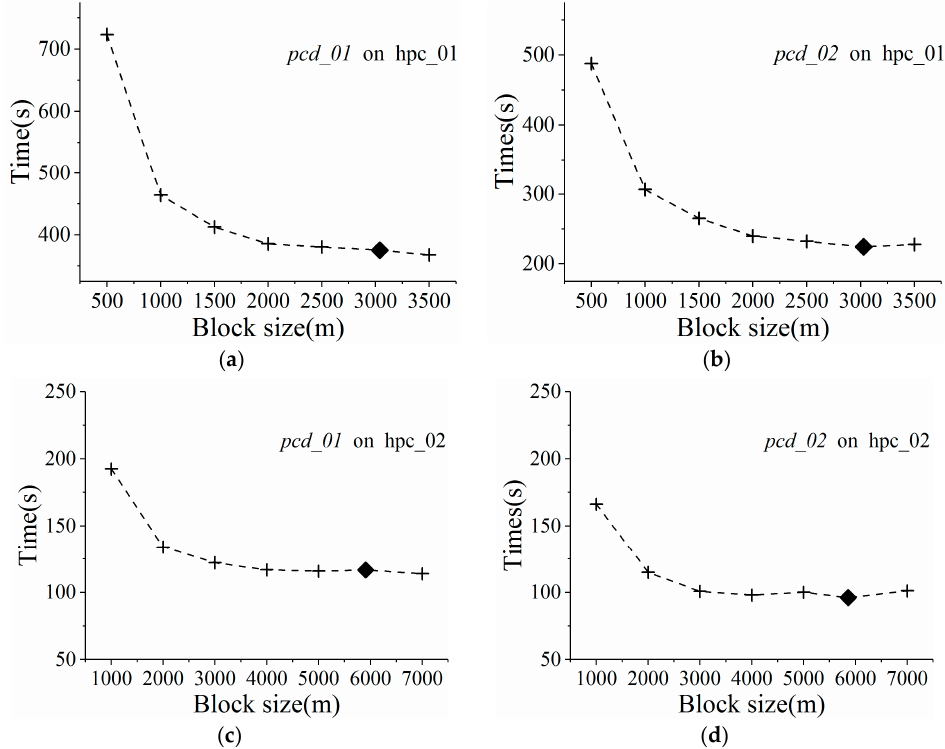
Figure 9. GPU interpolation time under different decomposition granularities. ( a ) pcd_01 on hpc_01; ( b ) pcd_02 on hpc_01; ( c ) pcd_01 on hpc_02; ( d ) pcd_02 on hpc_02.